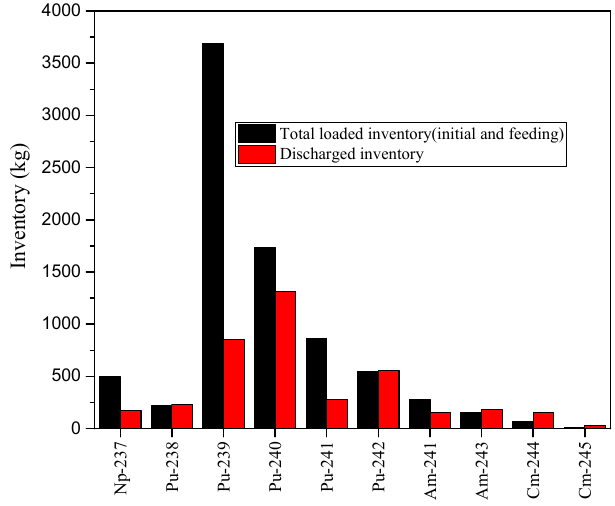
Figure 10. Total TRU-loaded inventory and residual TRU inventory after discharge.